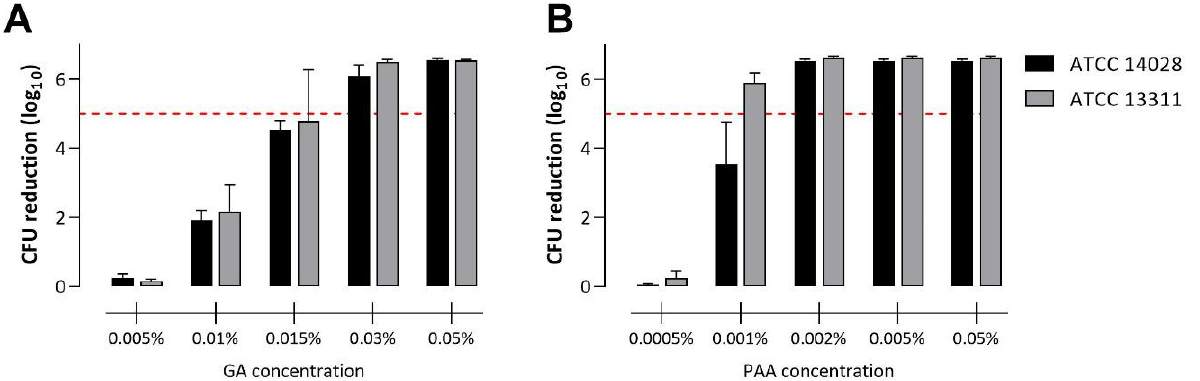
Figure 1. The efficacy of glutaraldehyde (GA) ( A ) and peracetic acid (PAA) ( B ) against planktonic cell suspensions of S. Typhimurium ATCC 14028 and ATCC 13311 evaluated with the quantitative suspension assay according to EN 1656. Bars represent mean log 10 reduction in CFU after GA or PAA treatment compared to the CFU of untreated control suspensions. Dashed lines indicate a 5 log 10 reduction in CFU and therefore successful